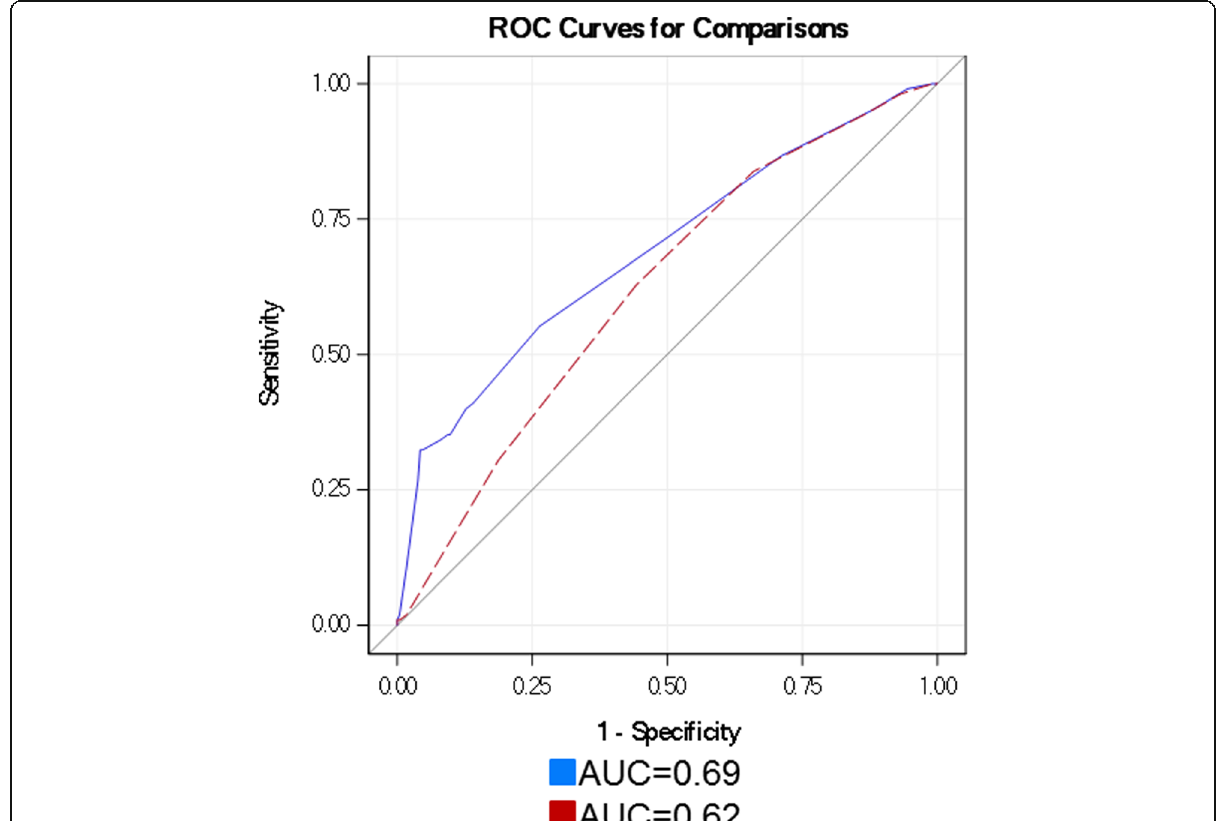
Fig. 2 AUC difference estimate, 0.07 (0.02, 0.11), p = 0.005. Abbreviations : AUC area under the curve, ROC receiver operator